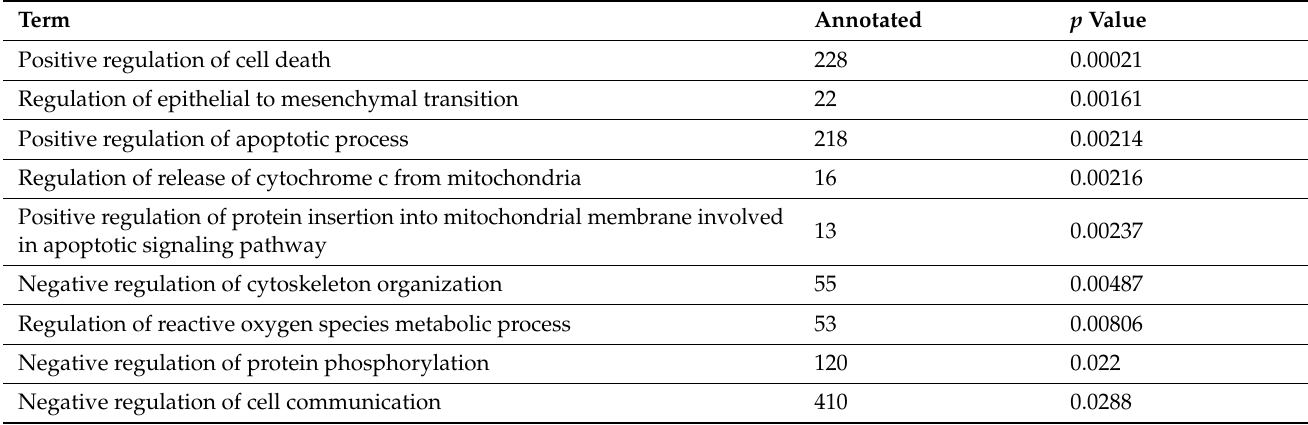
Table 3. Functional enrichment analysis in GO terms